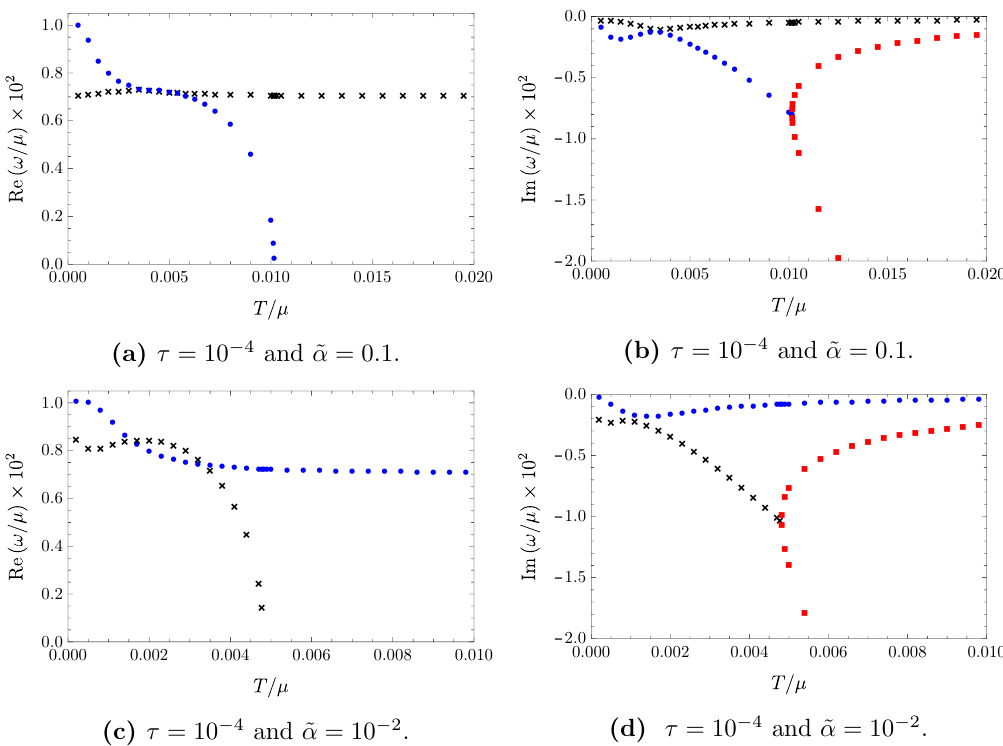
Figure 10. The same data as (cid:12)gure 9, but with separate plots for Re ( !=(cid:22) ) and Im ( !=(cid:22) ), each enhanced by 10 2 for clarity, versus T=(cid:22) . The color and shape coding are the same as in (cid:12)gure 9. (a) Re ( !=(cid:22) ) and (b) Im ( !=(cid:22) ) for (cid:28) = 10 (cid:0) 4 and ~ (cid:11) = 0 : 1. (c) Re ( !=(cid:22) ) and (d) Im ( !=(cid:22) ) for (cid:28) = 10 (cid:0) 4 and ~ (cid:11) = 10 (cid:0) 2